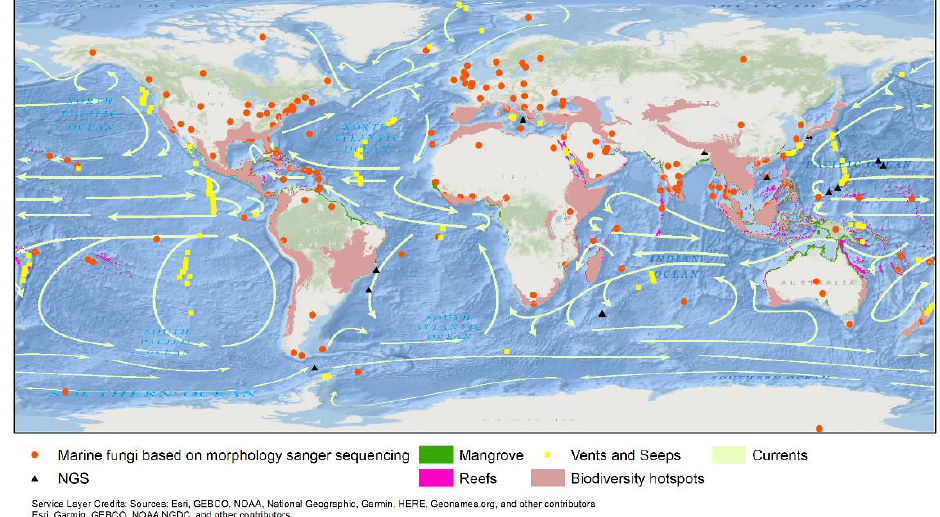
Figure 6. Distribution of marine species based on the Index Fungorum, accessed on 12 September 2022; www.marinefungi.org, accessed on 10 September 2022; and oceanic currents.